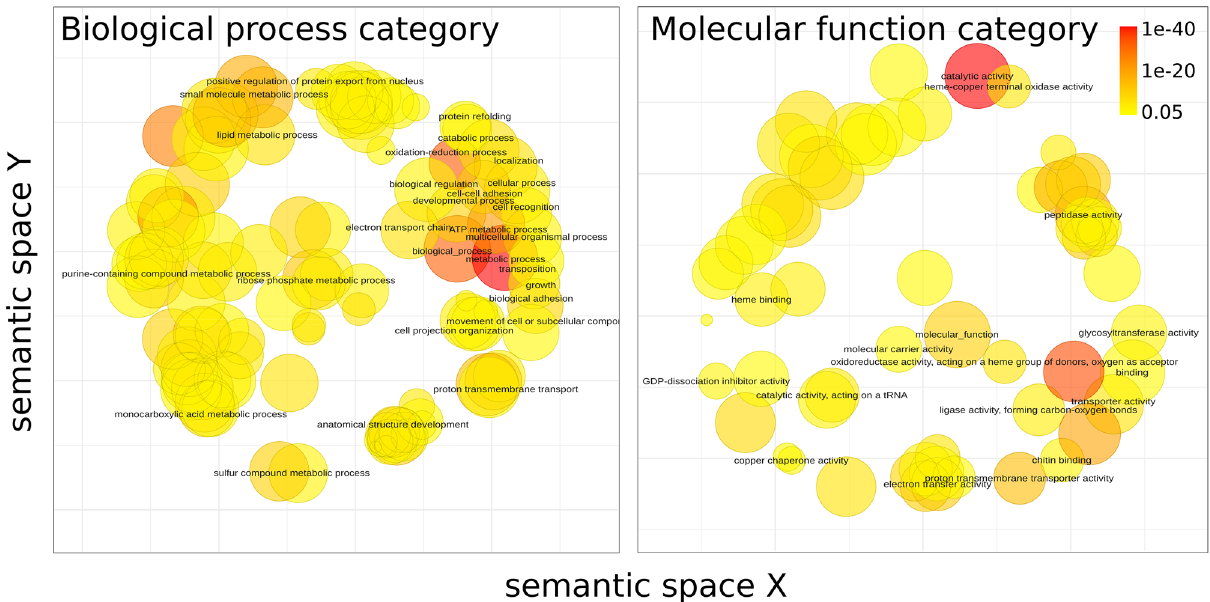
Figure 6. Gene ontology enrichment for genes primarily expressed during the embryonic and pupal stages. GO terms from the Biological Process aspect (left) and the Molecular Function aspect (right) are projected so that semantically close terms are spatially close. The color represents the adjusted p-value, multiplied over all the datasets. The size of circles reflects the log-transformed number of the term in the EBI GOA database 30 .